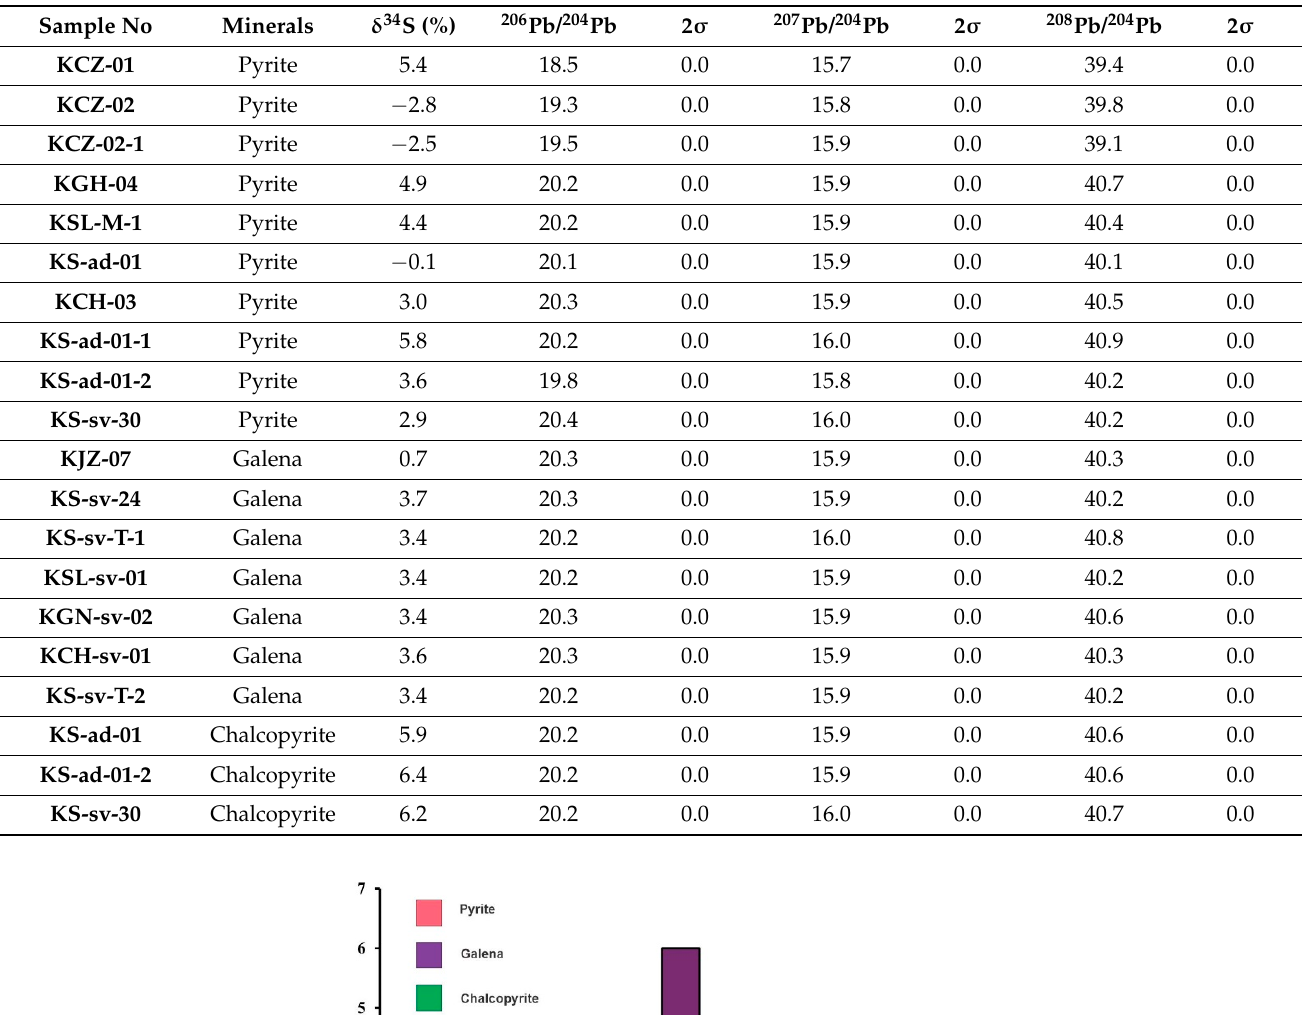
Table 5. Sulfur and lead isotope compositions of sulfide minerals from the Kargah Cu-Pb polymetallic deposit.